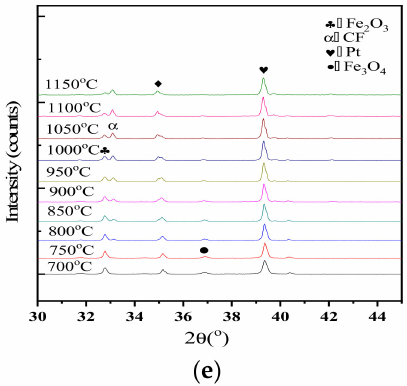
Figure 9. In-situ XRD data collected for samples with different Al 2 O 3 concentrations over the range 973 K to 1423 K (700 ◦ C to 1150 ◦ C) and 30 ◦ < 2 θ < 45 ◦ , showing the formation of CF. ( a ) 0 Al 2 O 3 , ( b ) 1.4% Al 2 O 3 , ( c ) 2.8% Al 2 O 3 , ( d ) 4.2% Al 2 O 3 , ( e ) 5.6% Al 2 O 3 .